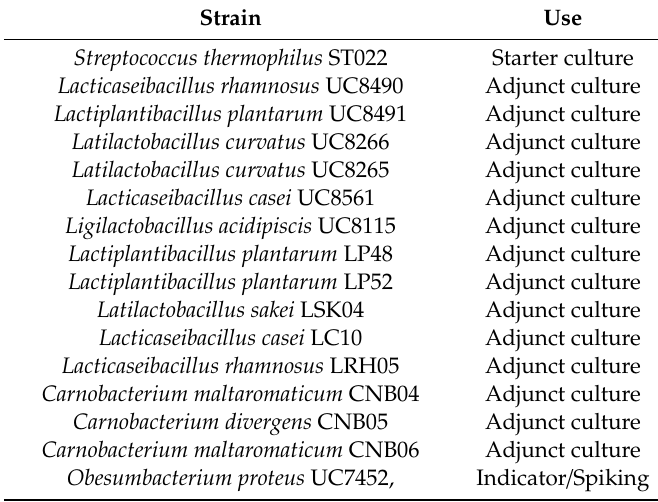
Table 1. List of bacterial strains used in this